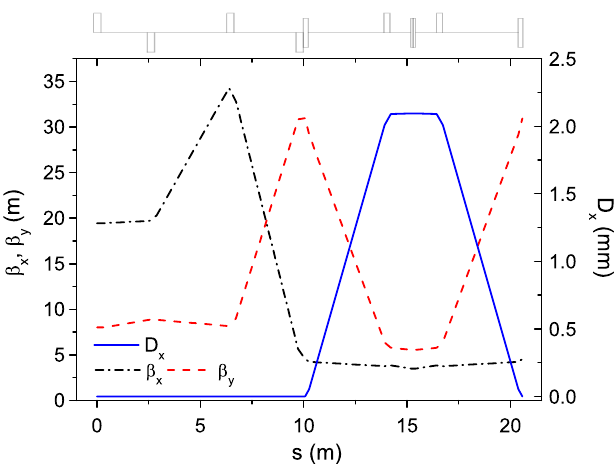
FIG. 7. (Color) Debunching properties of a first order isochronous bending system for (cid:3) The treatment is identical to that used in Fig.